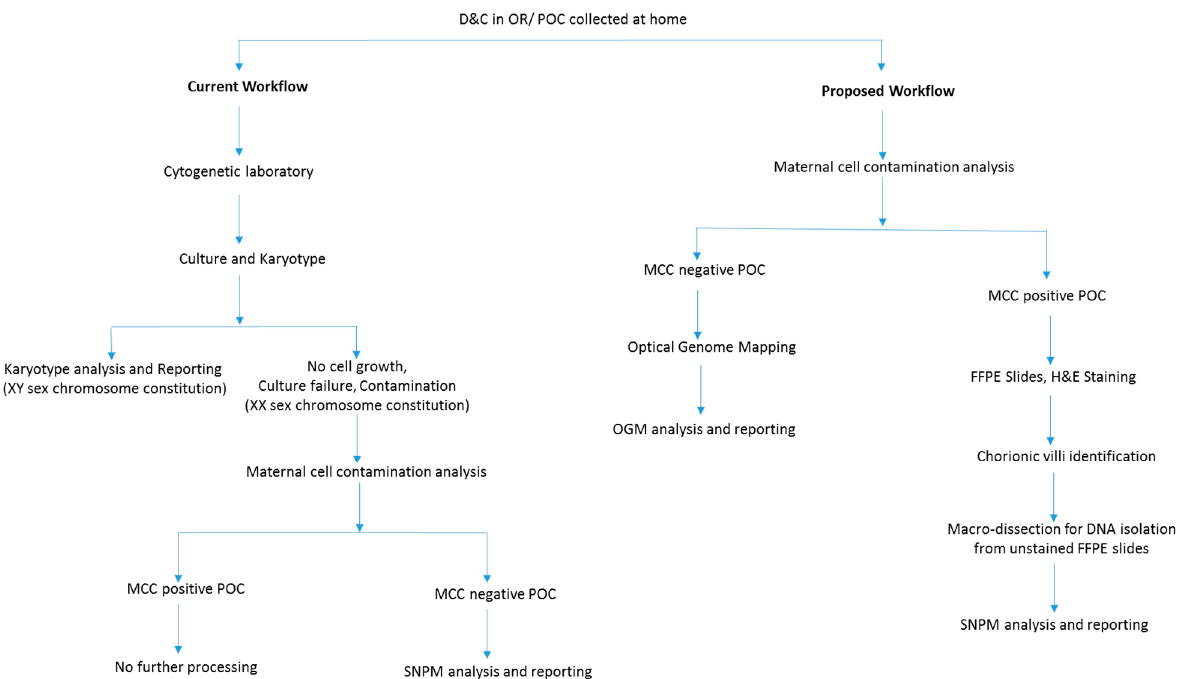
Figure 1. Flowchart depicting a modified diagnostic laboratory workflow compared to routine testing for high diagnostic yield in evaluating POC.